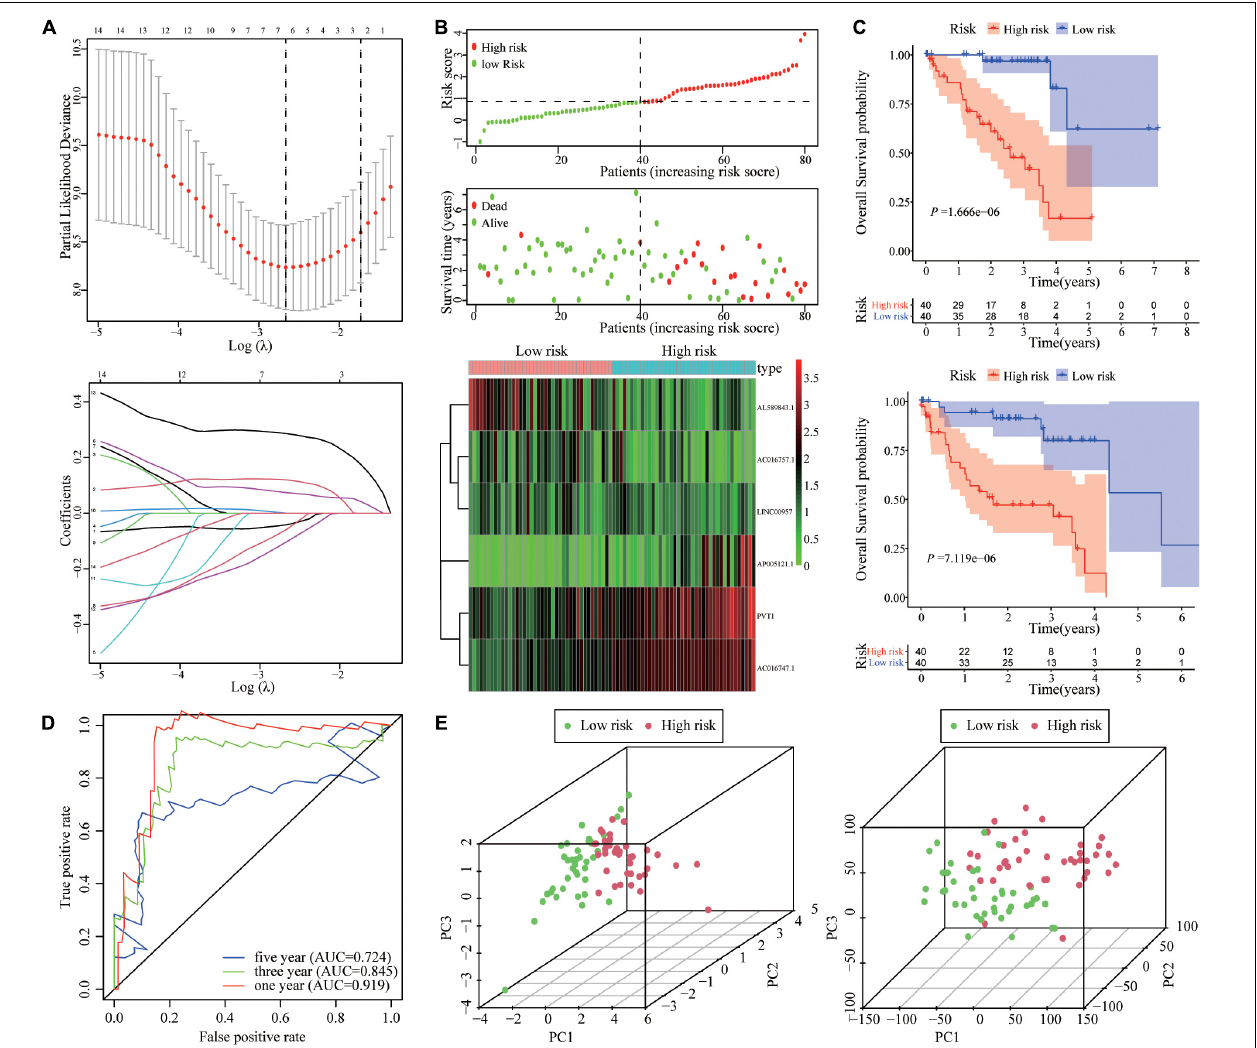
FIGURE 5 | Establishment and validation of autophagy-related lncRNA signature. (A) LASSO coefficient profiles of lncRNA signature for overall survival (OS) in TCGA cohort. (B) Risk score distribution, survival status scatter plots, and heat map of the six prognostic lncRNAs in the high-risk and low-risk groups. (C) Kaplan–Meier analysis showed that UM patients in the high-risk group had poorer OS and PFI compared with UM patients in the low-risk group. (D) Time-dependent ROC curve of the lncRNA signature at 1, 3, and 5 years. (E) PCA of the lncRNA signature in high-risk and low-risk groups.